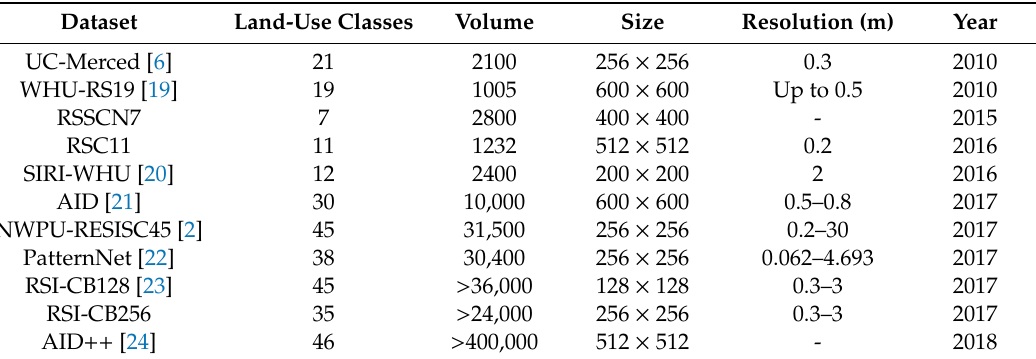
Table 1. Introduction of several typical scene